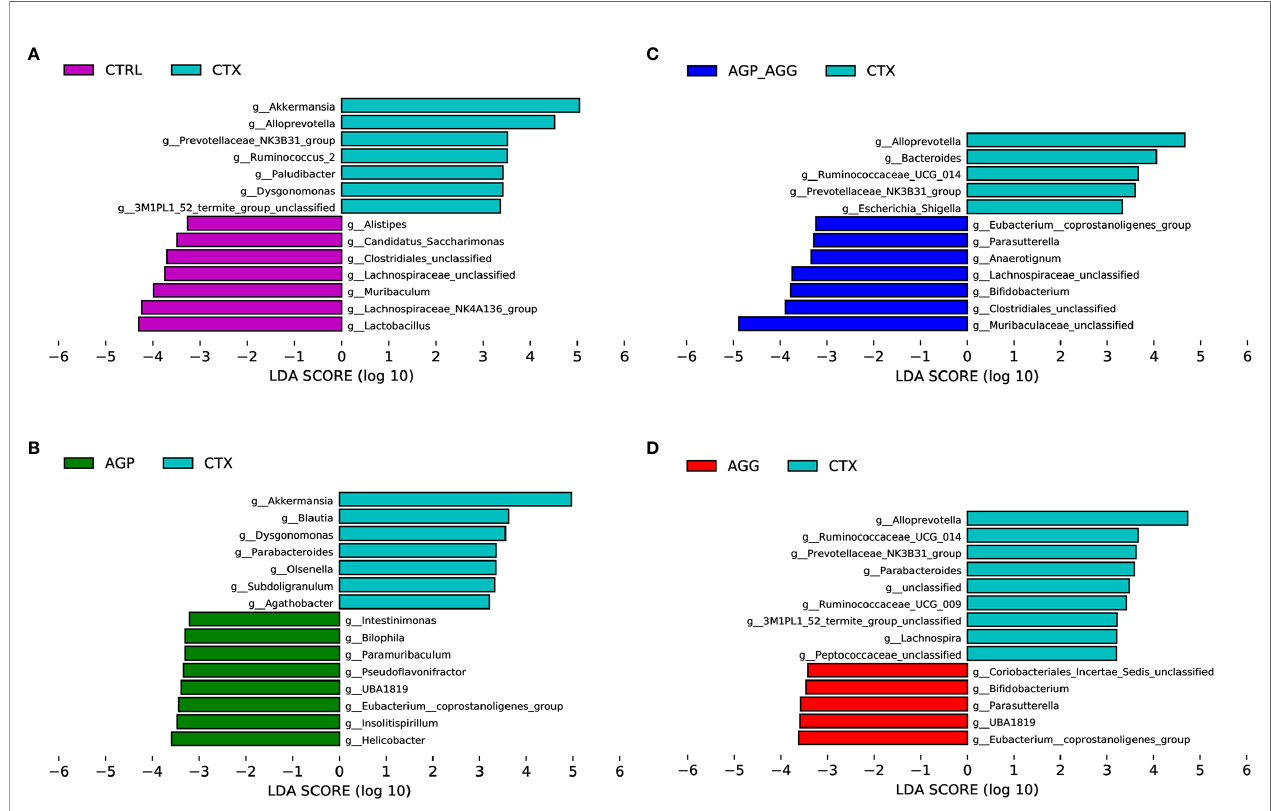
FIGURE 6 | Bacterial communities ’ differences obtained by linear discriminant analysis (LDA) analysis. (A) LDA results between the CTRL and CTX groups. (B) LDA results between the AGP_AGG and CTX groups. (C) LDA results between the AGP and CTX groups. (D) LDA results between the AGG and CTX groups. Only the genus level with a signi fi cant logarithmic LDA threshold score of > 3.2, Wilcoxon rank-sum test, p < 0.05 were shown. Different-colored regions represent different groups. CTRL, control group; CTX, cyclophosphamide-induced immunosuppressive group; AGP_AGG, American ginseng polysaccharide+American ginseng ginsenoside with cyclophosphamide-induced immunosuppressive group; AGP, American ginseng polysaccharide with cyclophosphamide-induced immunosuppressive group; AGG, American ginseng ginsenoside with cyclophosphamide-induced immunosuppressive